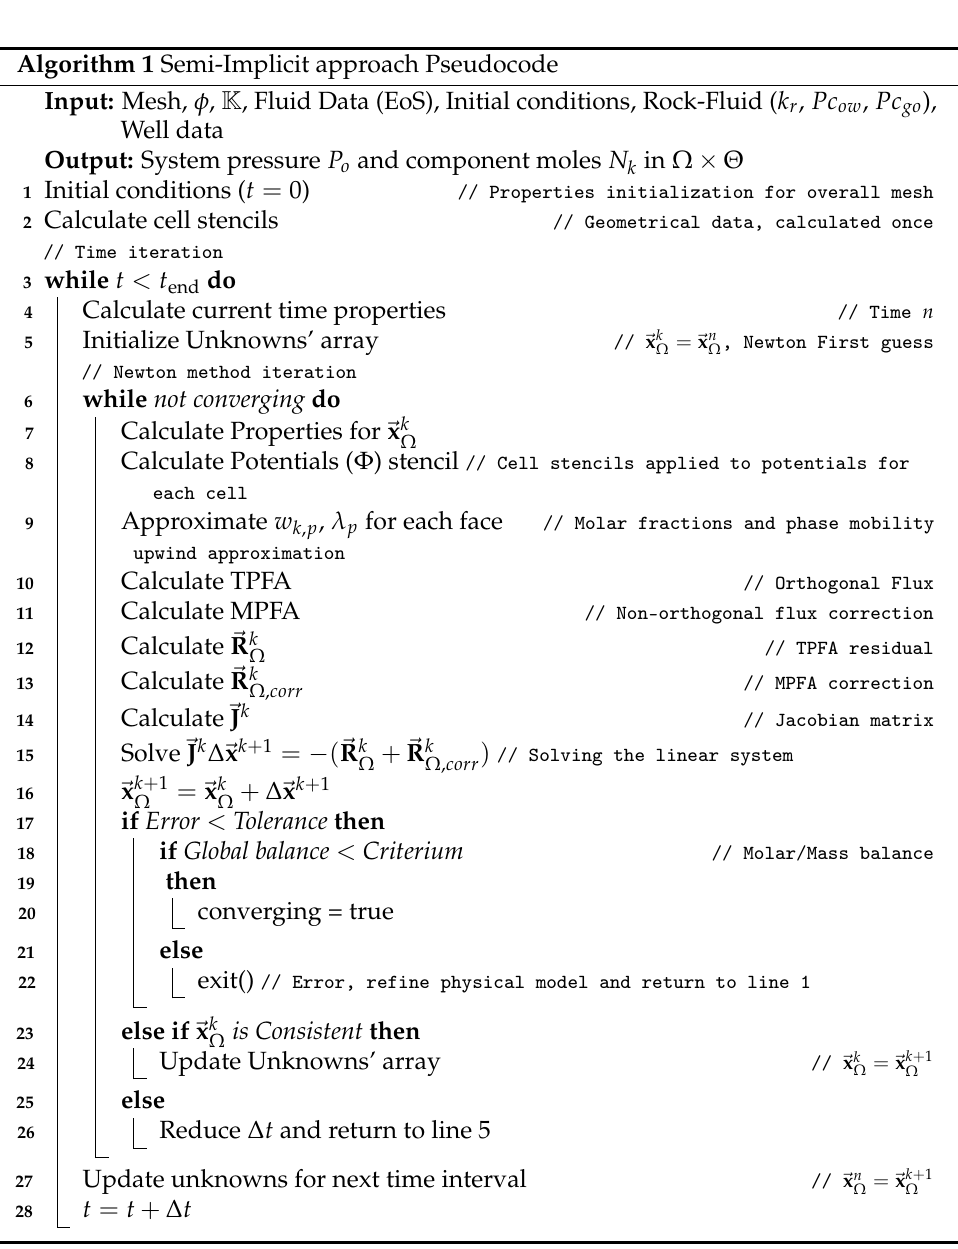
Algorithm 1 Semi-Implicit approach